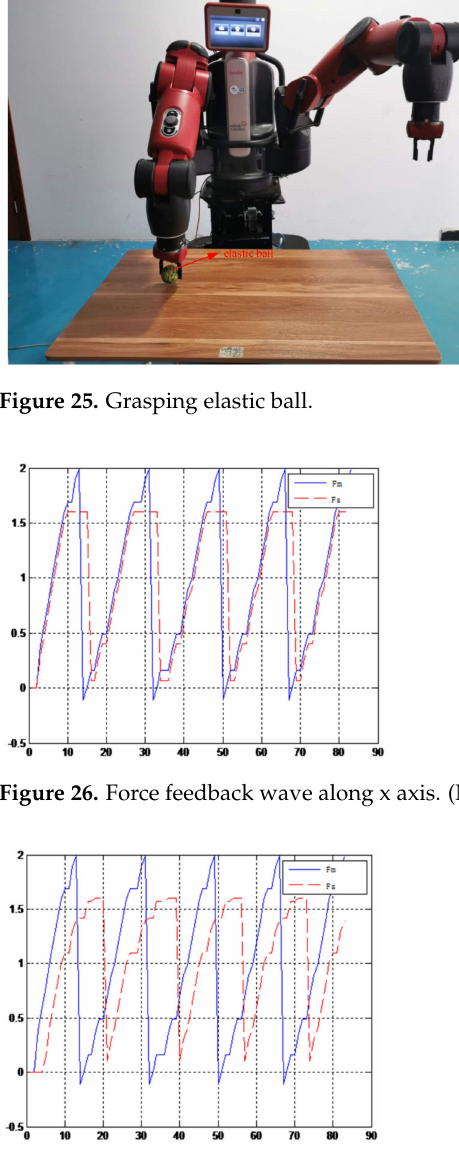
Figure 27. Force feedback wave along x axis. (Constant time delay, elastic